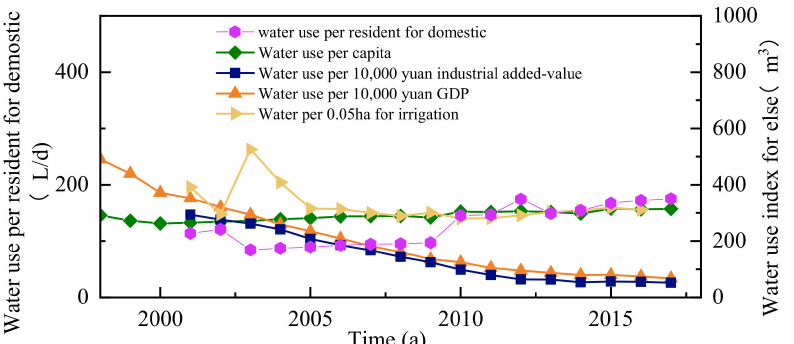
Figure 8. Changes in water use indices in the upstream Yangtze River.